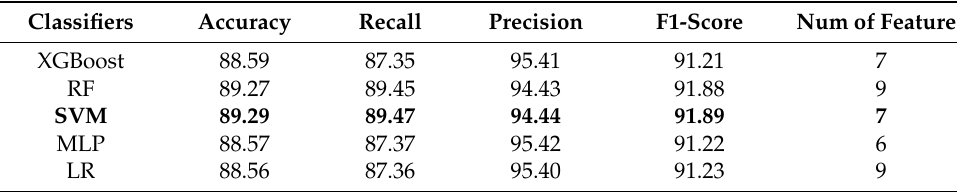
Table 2. Best performance results of the employed ML models.